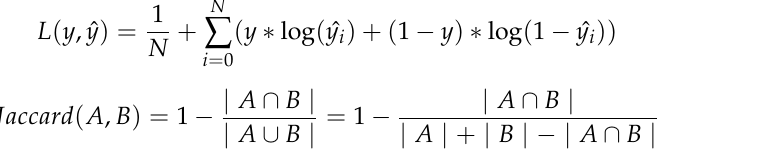
Table 2. Number of trainable parameters and epochs of the best models.